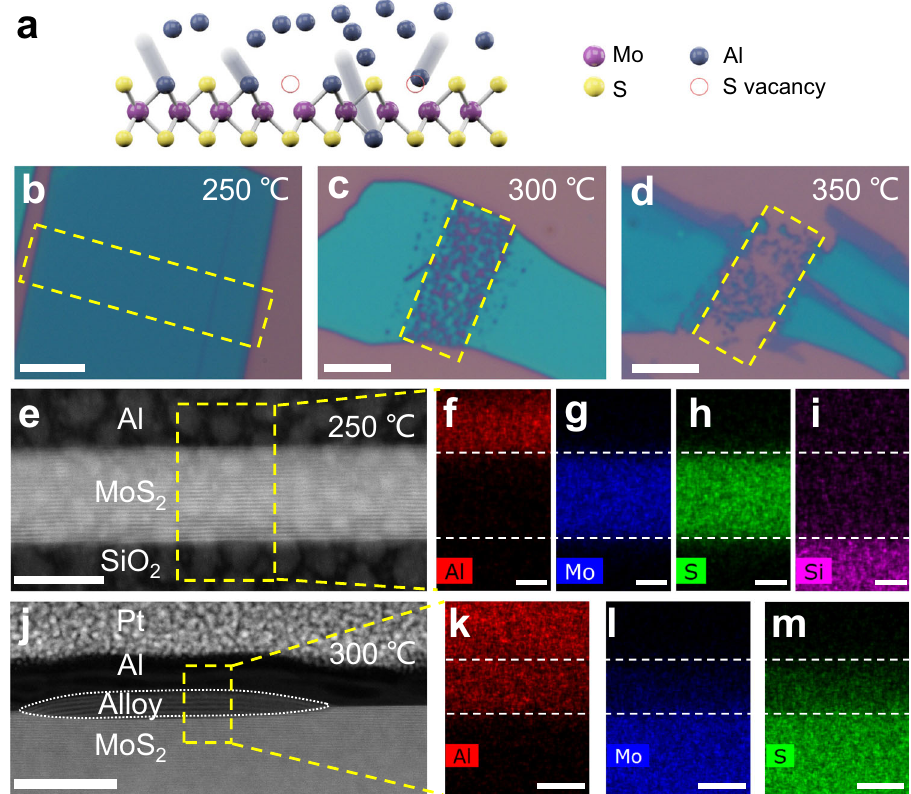
Fig. 1 Uncontrollable thermal diffusion of Al atoms into pristine MoS 2 lattices. a Schematic diagram for the thermal diffusion process, where randomly distributed surfacial defects serve as the starting sites to guide the diffusion inside the MoS 2 lattices. b – d Typical optical images of three acid-washed MoS 2 samples after one-hour thermal diffusion of Al at T a = 250, 300, and 350 °C, respectively. The dashed yellow rectangles outline the areas of locally deposited sacri fi cial metal Al strips. Scale bars, 5 μ m. e – i Cross-sectional HAADF image and corresponding elemental mappings for a typical Al/MoS 2 / SiO 2 stack annealed at 250 °C. The dashed white lines in f – i highlight the two sharp interfaces of MoS 2 . Scale bars in e and f – i are 20 and 6 nm, respectively. j – m Cross-sectional HAADF image and corresponding elemental mappings for a typical Al/MoS 2 stack annealed at 300 °C. The dotted white line in j shows the alloy region between Al and MoS 2 . The dashed white lines in k – m highlights the interfaces of Al/alloy and alloy/MoS 2 . Scale bars in j and k – m are 40 and 6 nm,